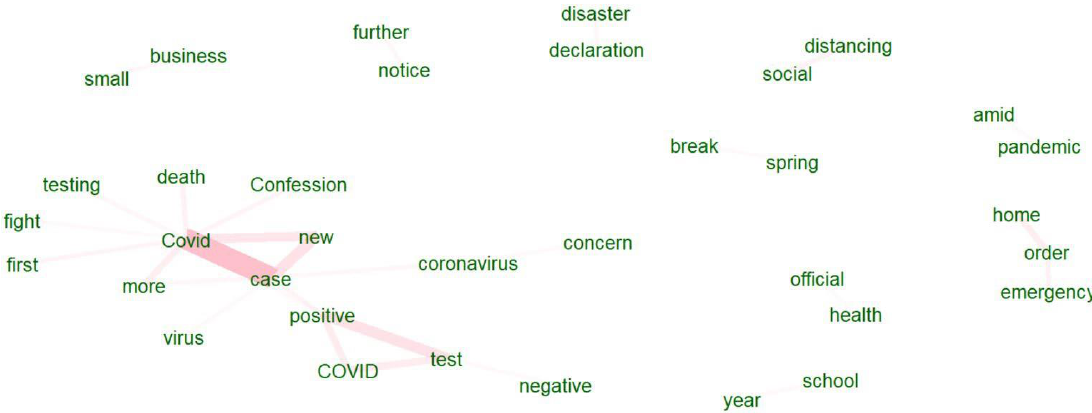
Figure 6. Co-occurrences within three words’ distance: nouns and adjectives (The Monitor).